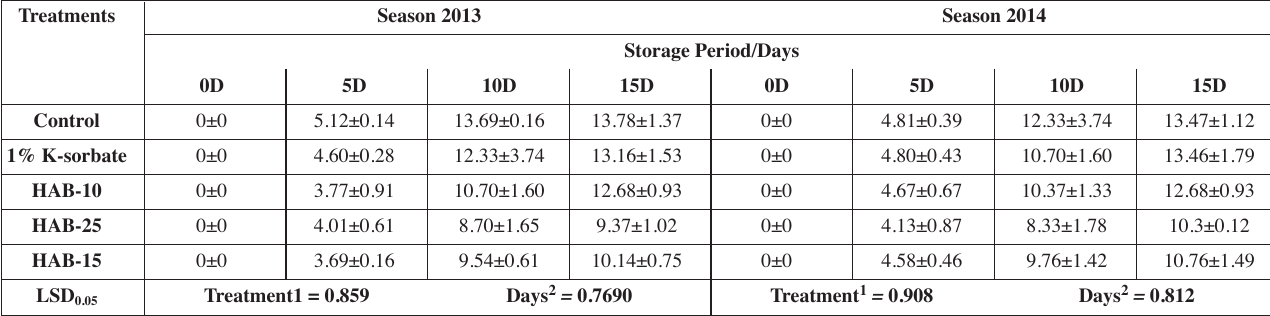
Tab. 3: Effect of fluorescent Pseudomonas species on the weight loss of tomato stored at 23±4 ºC with relative humidity in the range of 25% - 70%. Treatments